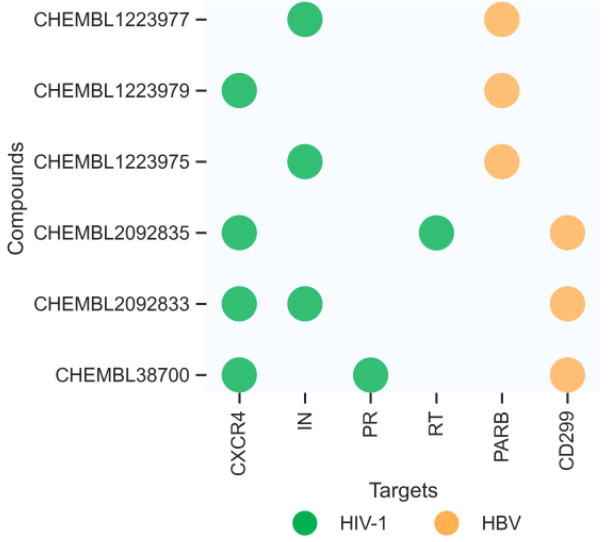
Figure 9. The distribution of multitargets predicted by our ensemble model for the six new com- pounds.